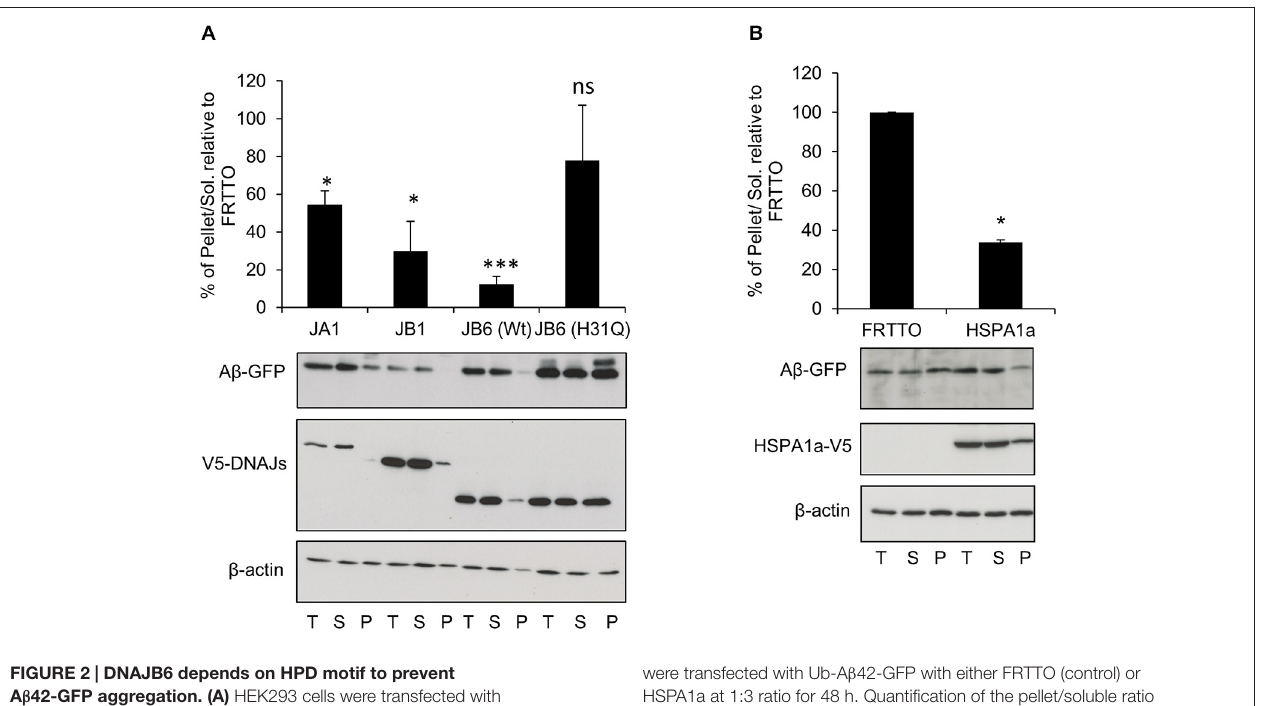
FIGURE 2 | DNAJB6 depends on HPD motif to prevent A β 42-GFP aggregation. (A) HEK293 cells were transfected with Ub-A β 42-GFP with either DNAJA1, DNAJB1, DNAJB6 (Wt), DNAJB6 (H31Q) mutants at 1:3 ratio for 48 h. Cells were lysed, fractionated into T, S, P and Western blotting was performed (B) HEK293 cells